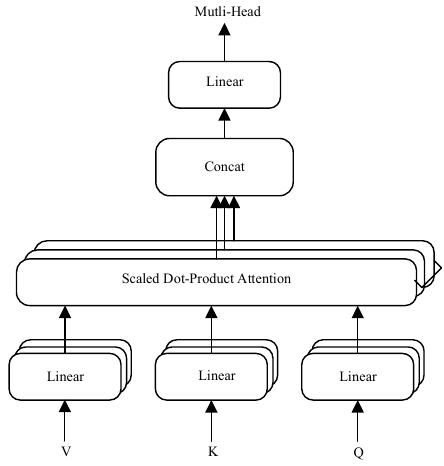
Figure 5. Multi-head attention. Figure 5. Multi‑head